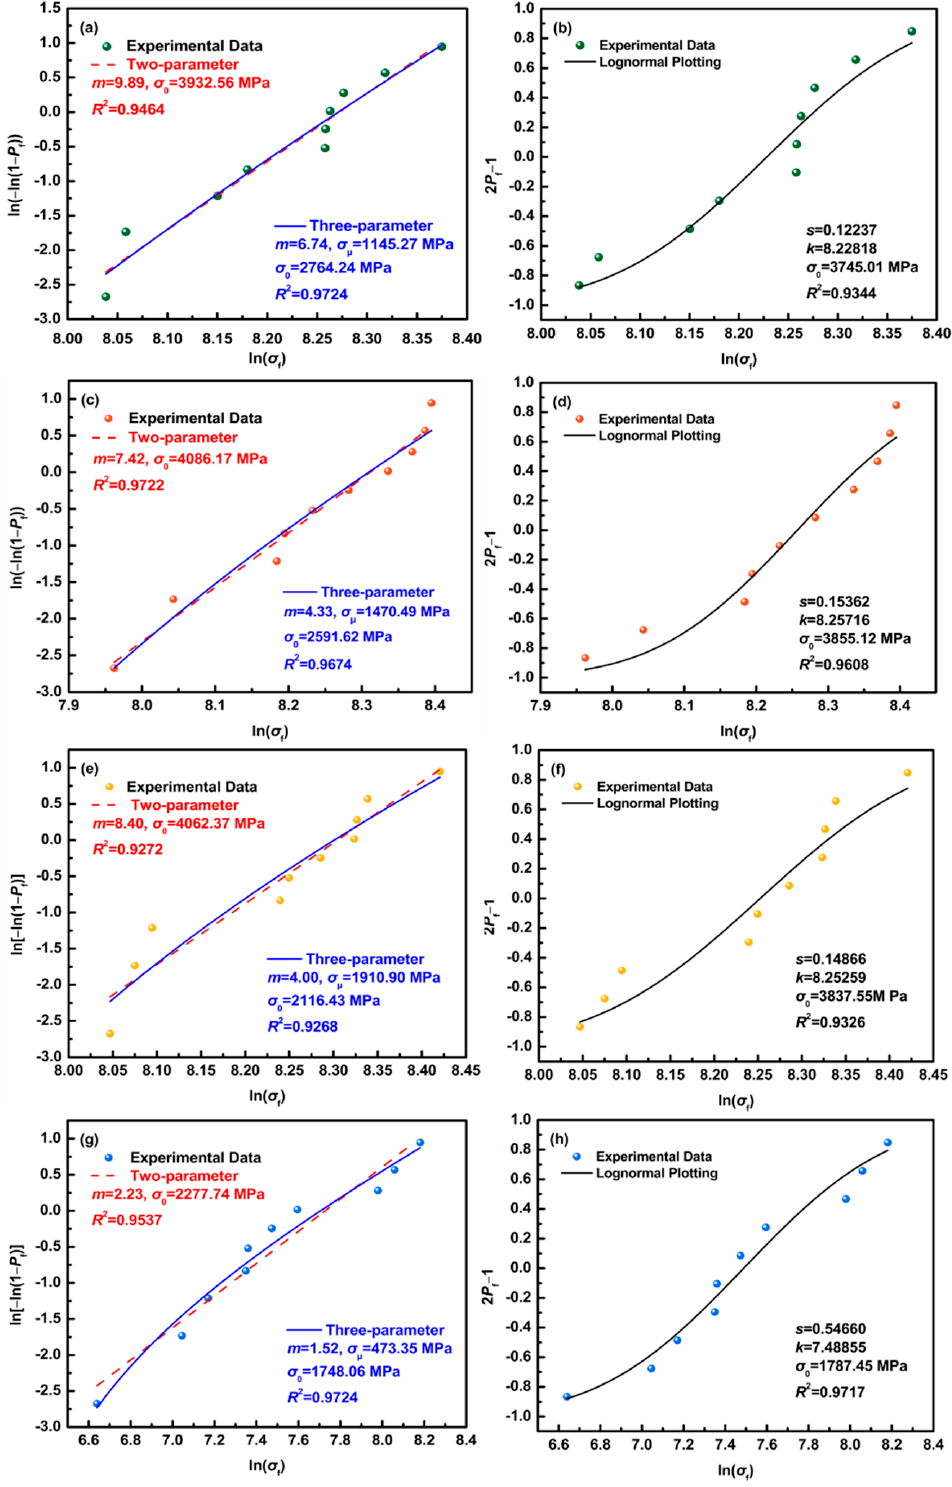
Figure 6. Fracture reliability analysis treated by multitype plotting (two- and three-parameter Weibull statistics and log-normal plotting) of as-cast and direct current-annealed Co-based metallic microwires: ( a , b ) as-cast; ( c , d ) 65 mA; ( e , f ) 90 mA; ( g , h ) 150 mA.